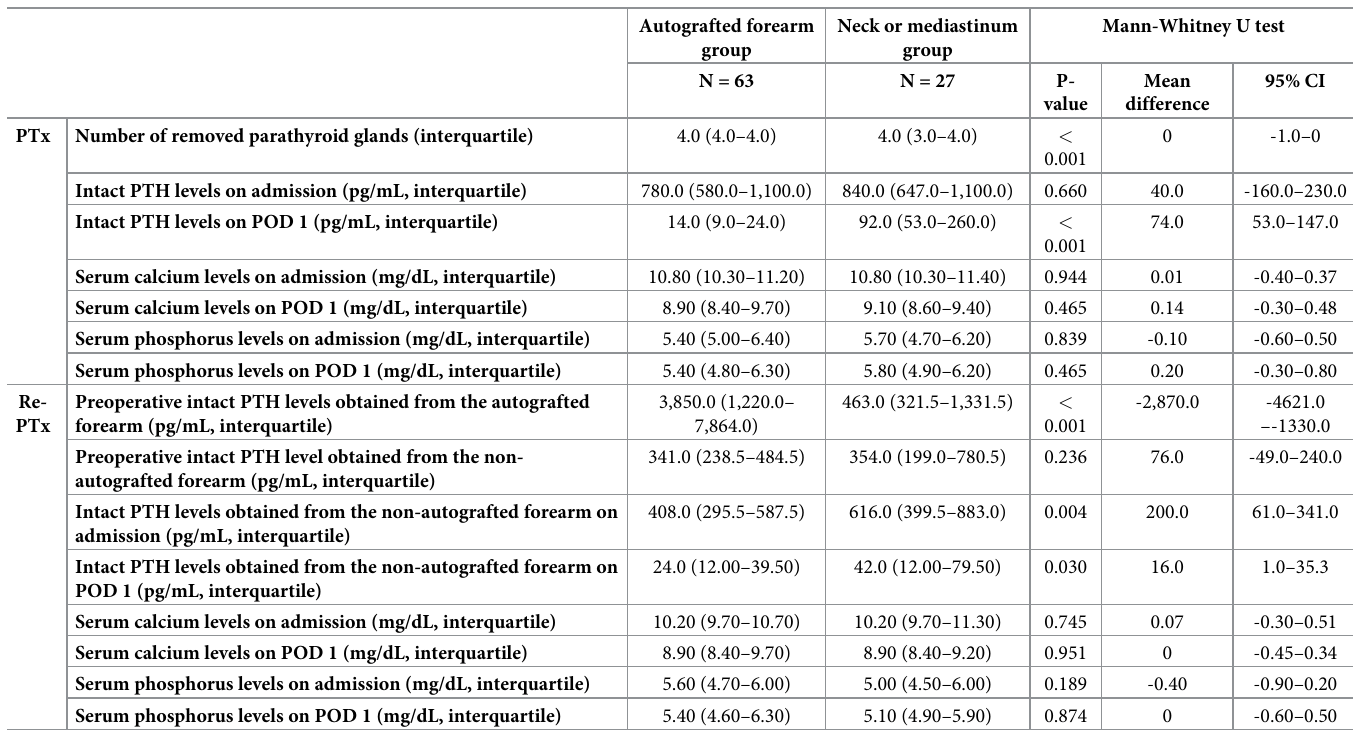
Table 2. The details of parathyroidectomy and